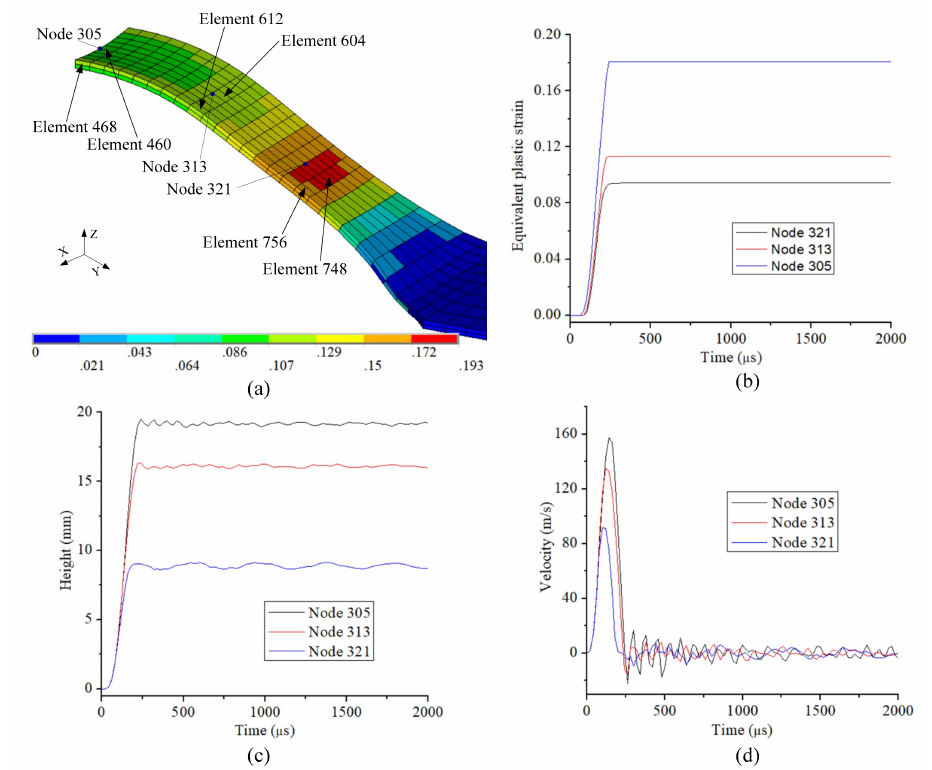
Figure 12. Dynamic deformation: ( a ) 3D shape and equivalent plastic strain, ( b ) plastic strain with time, ( c ) height with time, and ( d ) velocity with